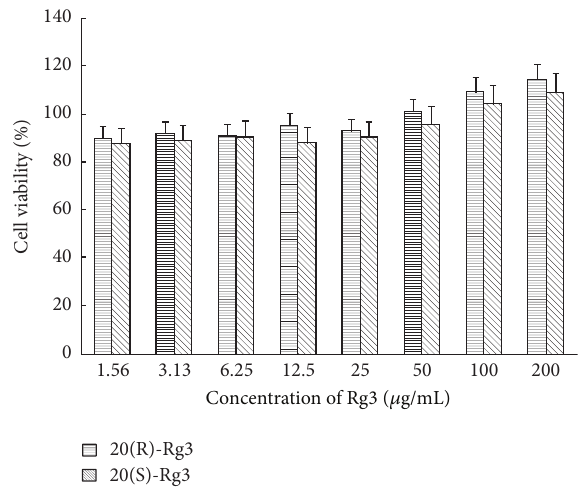
Figure 2: Cytotoxicity effects of ginsenoside Rg3 on SK-N-SH